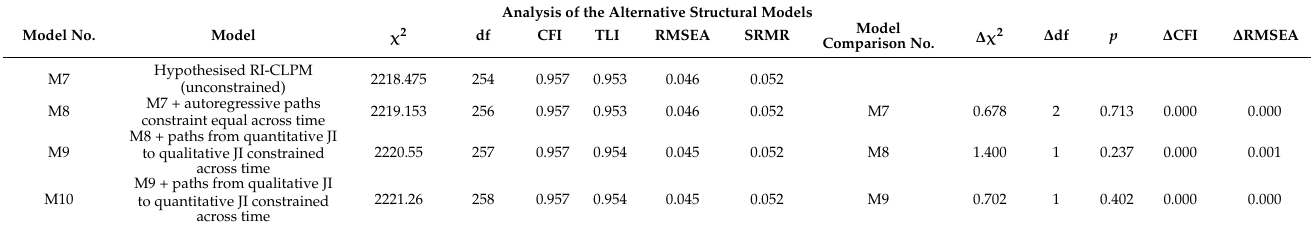
Table 3. Time invariance of the structural paths. AnalysisoftheAlternativeStructuralModels